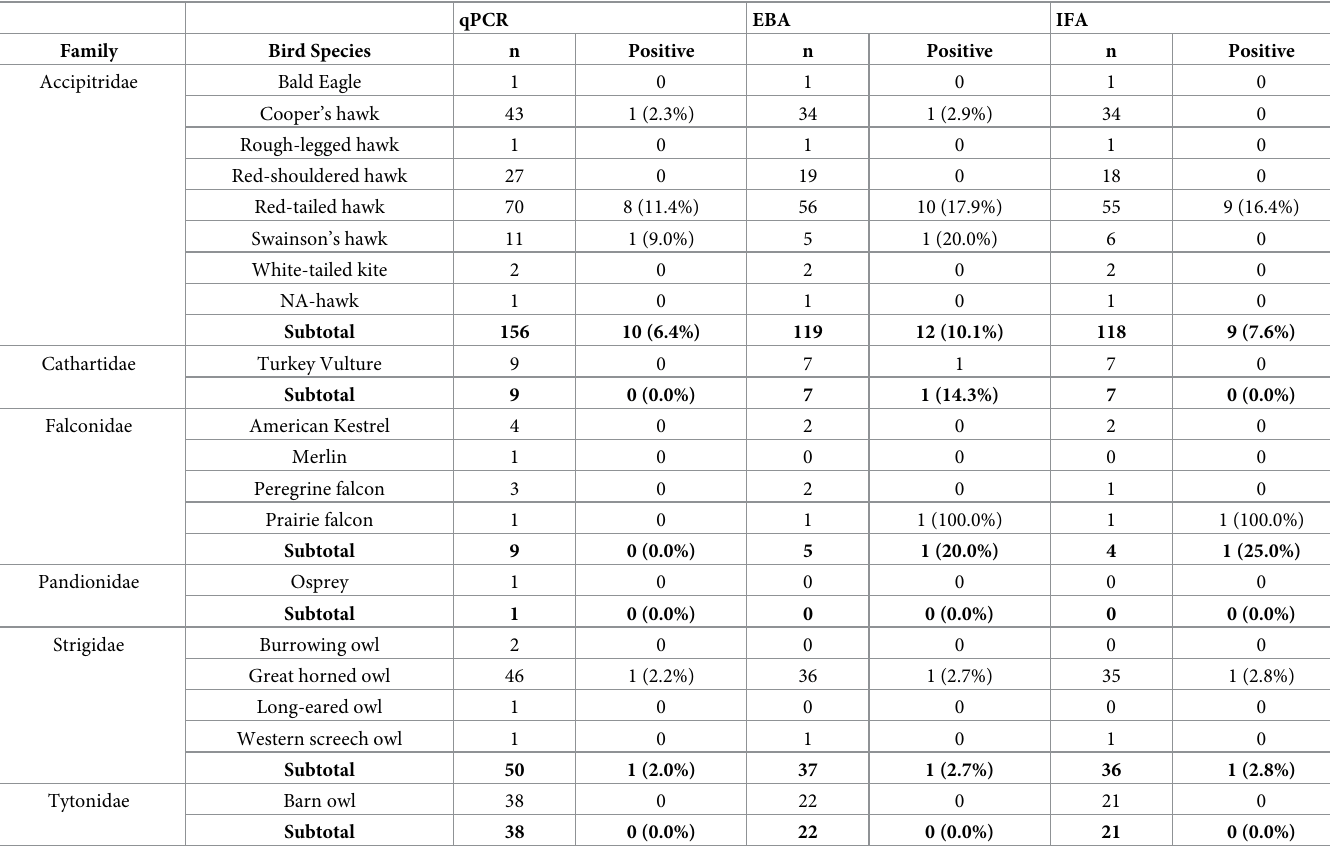
Table 1. Results for chlamydial DNA and serology (elementary body agglutination; EBA and immunofluorescent antibody; IFA) by raptor